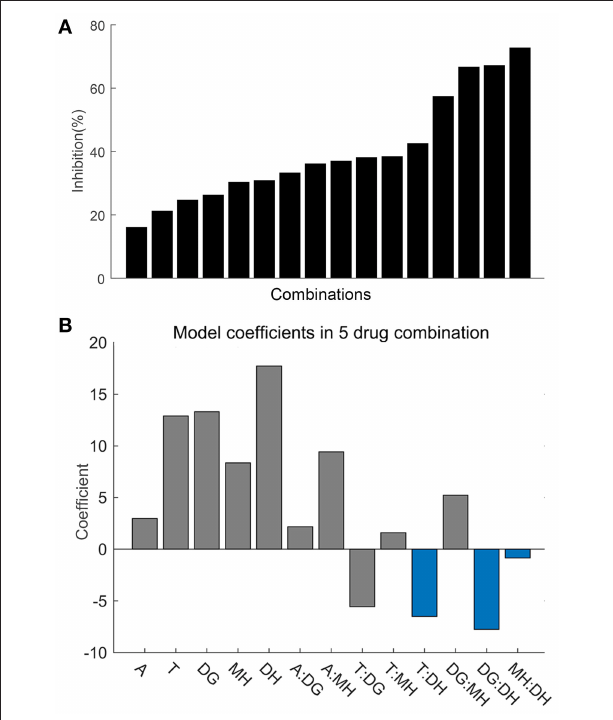
FIGURE 4 | Results and data analysis of the 5-drug combination system. (A) The anti-platelet efficacies of the 16 drug combinations of 5-drug system investigated in generation 2. (B) Regression coefficients from the interaction model are provided based on the obtained data in (A) . Negative regression value indicates that increasing the dose of the drug reduces the inhibition ability of the combination. Thus the model allows for the elimination of the least active drug. The 5-hydroxymethyl furfuraldehyde related drug-drug interaction terms are all negative as highlighted by blue, indicating 5-hydroxymethyl furfuraldehyde was the least active drug in the combination. A, aspirin; T, ticagrelor; DG, ferulic acid; MH, forskolin; DH, 5-hydroxymethyl furfuraldehyde.